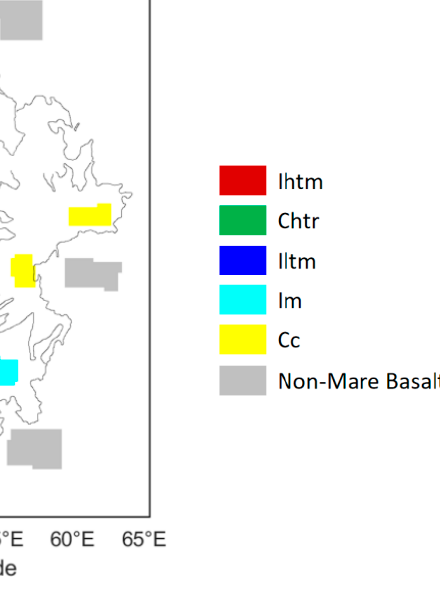
Figure 4. Map of labeled study samples.